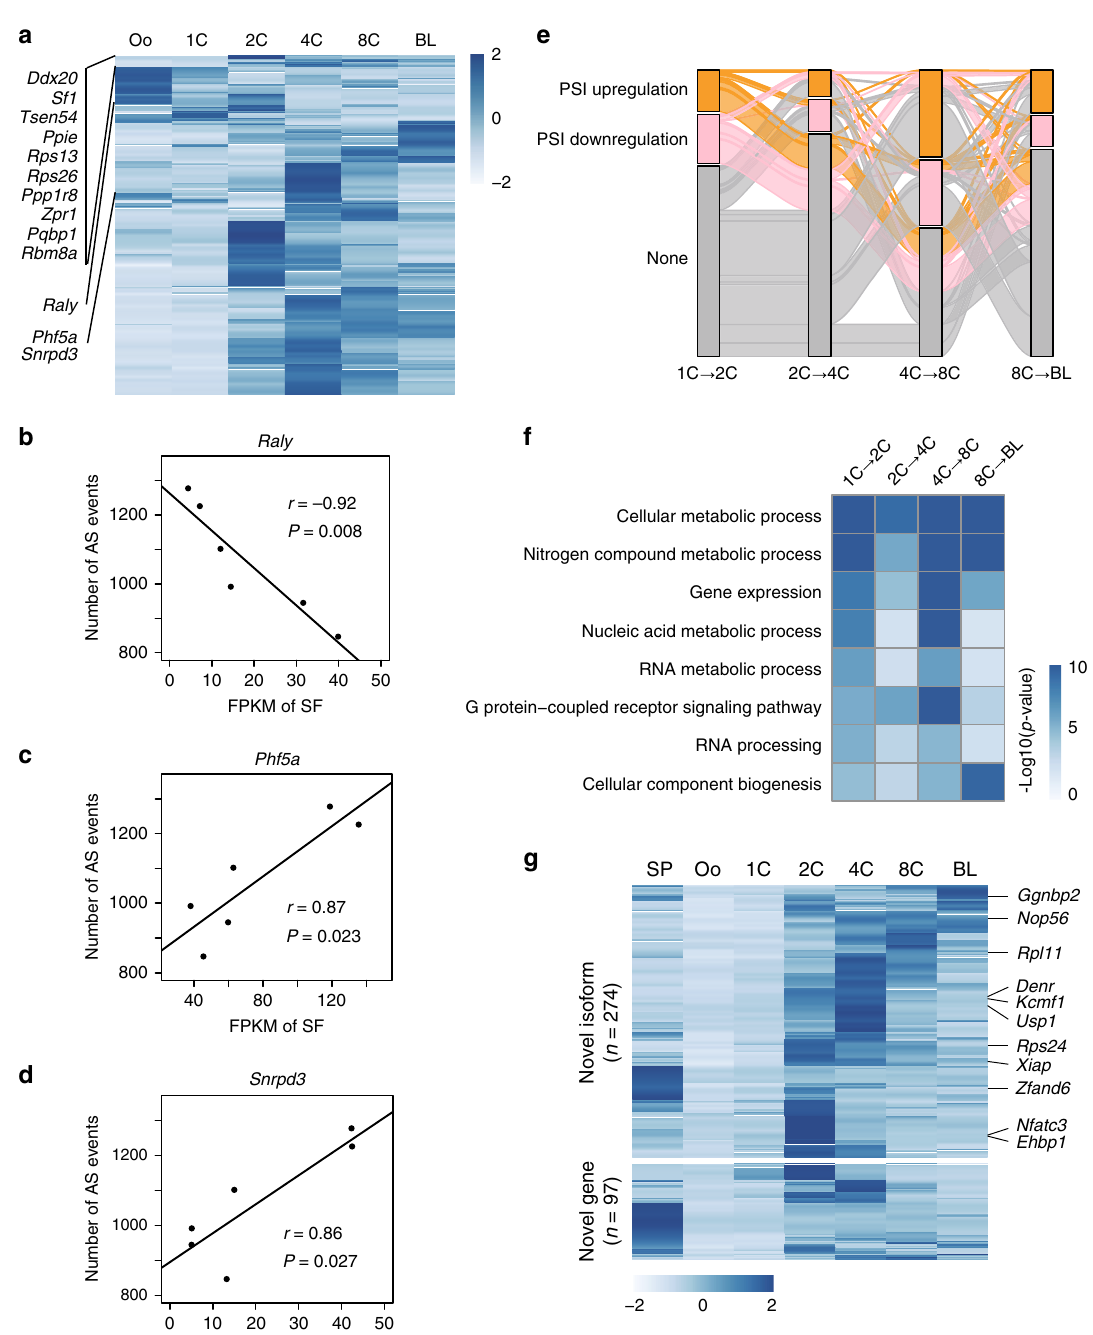
Fig. 4 AS dynamics during preimplantation embryo development. a Heatmap showing the expression of splicing factors in six stages. Heatmap shows Z -scores of FPKM by row. The representative splicing factors that were activated during 1-cell to 2-cell transition were also presented. b – d Pearson correlation between expression of Raly ( b ), Phf5a ( c ), and Snrpd3 ( d ) and number of AS events in six stages (from oocyte to blastocyst). e The global dynamics of differential splicing events during early embryo development. Each column represents the tracking trace for differential AS events between adjacent stages. Each bar represents the class of differential splicing events. Up: PSI upregulated; down: PSI downregulated; none: AS events showing no difference. f The GO enrichment analysis of biological processes for differential splicing events in adjacent stages. g Heatmap showing the expression of novel transcripts (including novel isoforms and novel genes) that was upregulated during the 1-cell to 2-cell transition. The heatmap shows the Z -score of TPM by